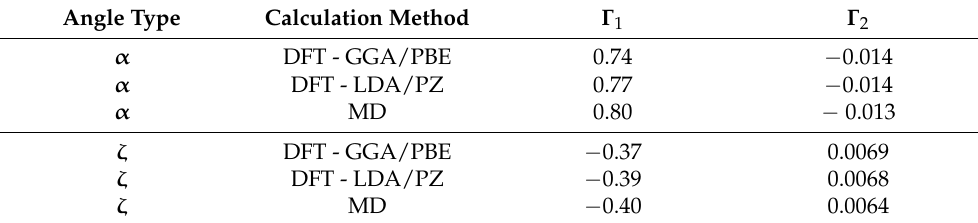
Table 4. Coefficients Γ 1 [in deg/(%strain)] and Γ 2 [in deg/(%strain) 2 ] of the strain dependence of the angles [see Equation (2)] for the bond angles of type α and ζ , when the strain is applied along the zigzag direction, as obtained by the results of the different theoretical methods used in this